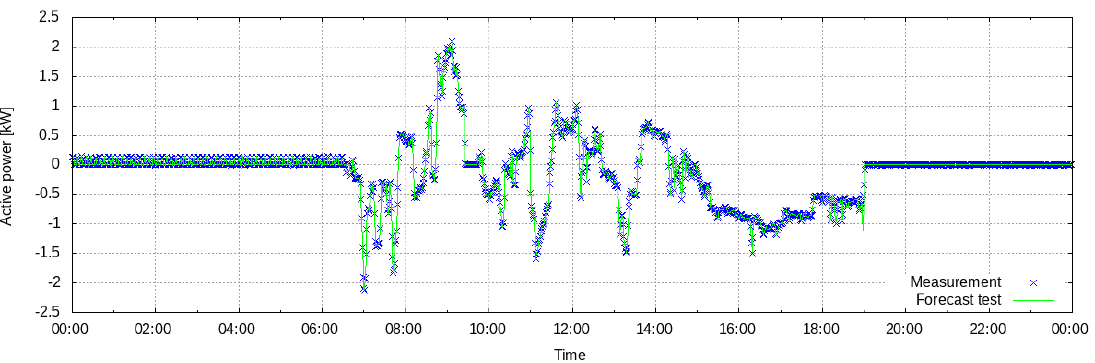
Figure 8. Ground truth and prediction of the power consumed by the battery within a 24-h forecast horizon for 2 May 2017.